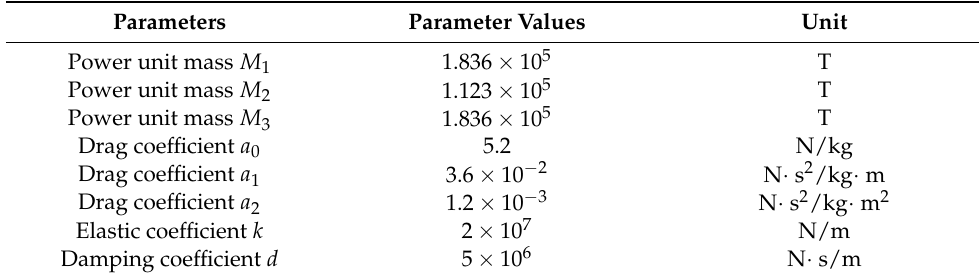
Figure 4. Simulation experiment device of CRH380A high speed EMUs. Table 1. The CRH380A EMUs model